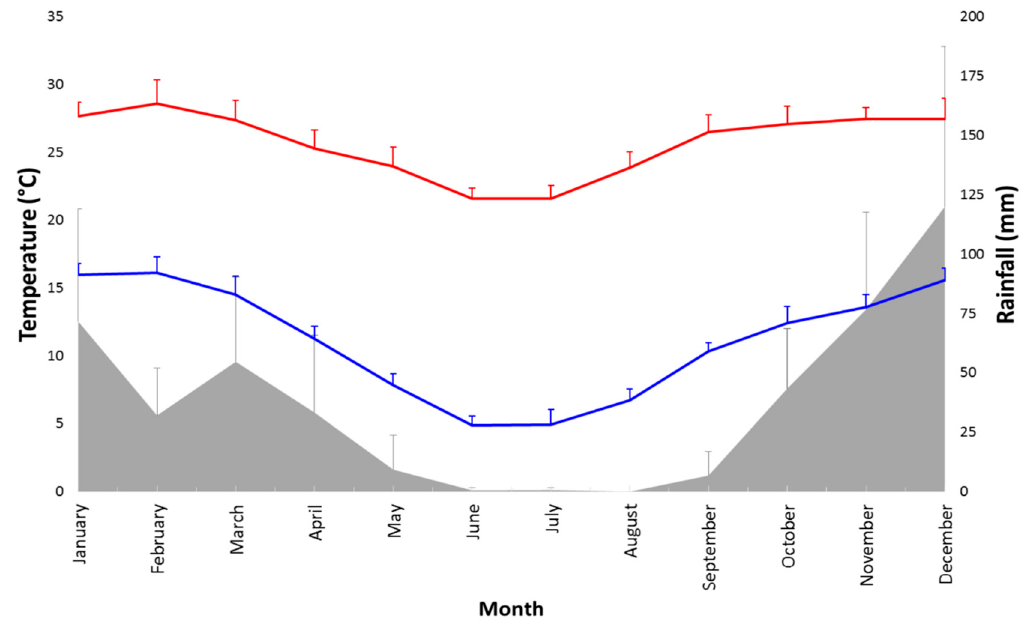
Figure A3. Monthly temperature and rainfall data for the study area averaged over a six-year period from 2012–2017. The red line and data points indicate maximum monthly temperatures, the blue line and data points represents minimum temperatures, and the shaded grey area indicates average monthly rainfall. Error bars indicate the standard deviation per month between the years. (Weather data provided by the South African Weather Service).